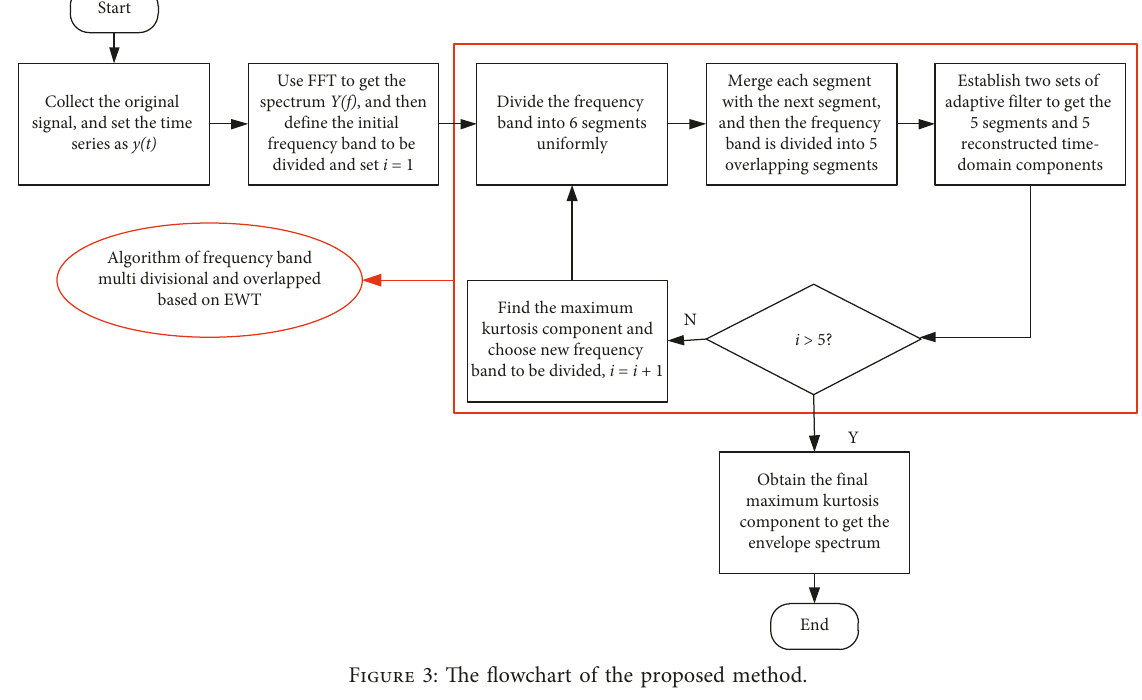
Figure 3: The flowchart of the proposed method.